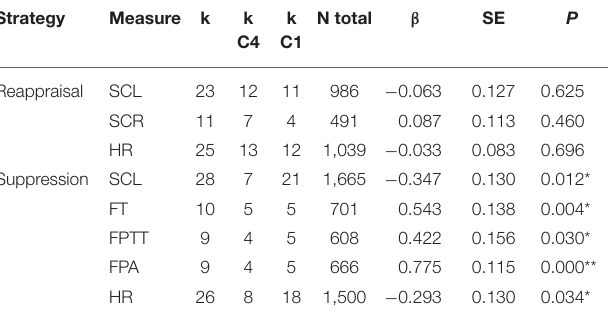
TABLE 6 | Moderator analyses on nature of control instruction (instruction to respond naturally vs. no instruction). Strategy